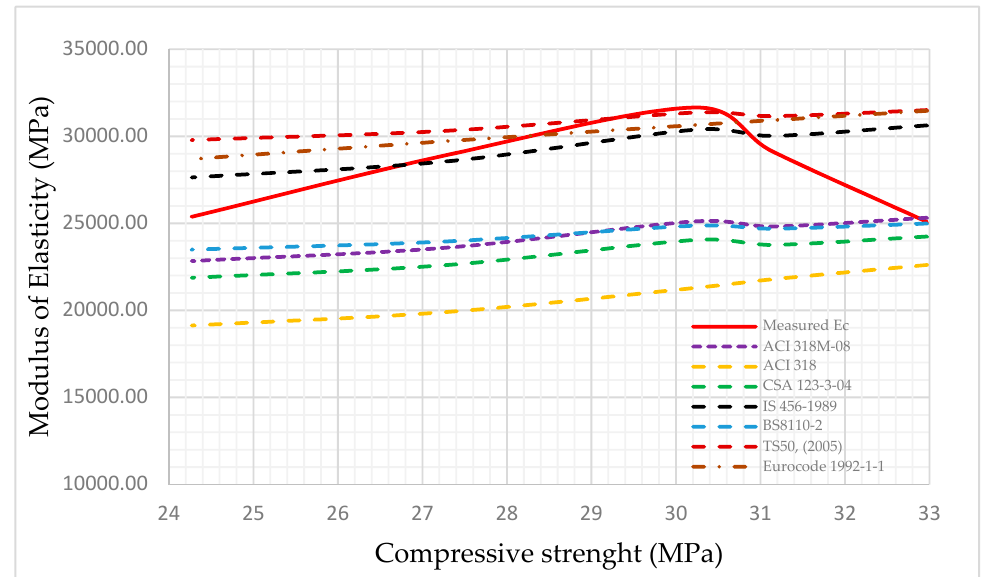
Figure 9. Comparison of the measured and predicted E c values.